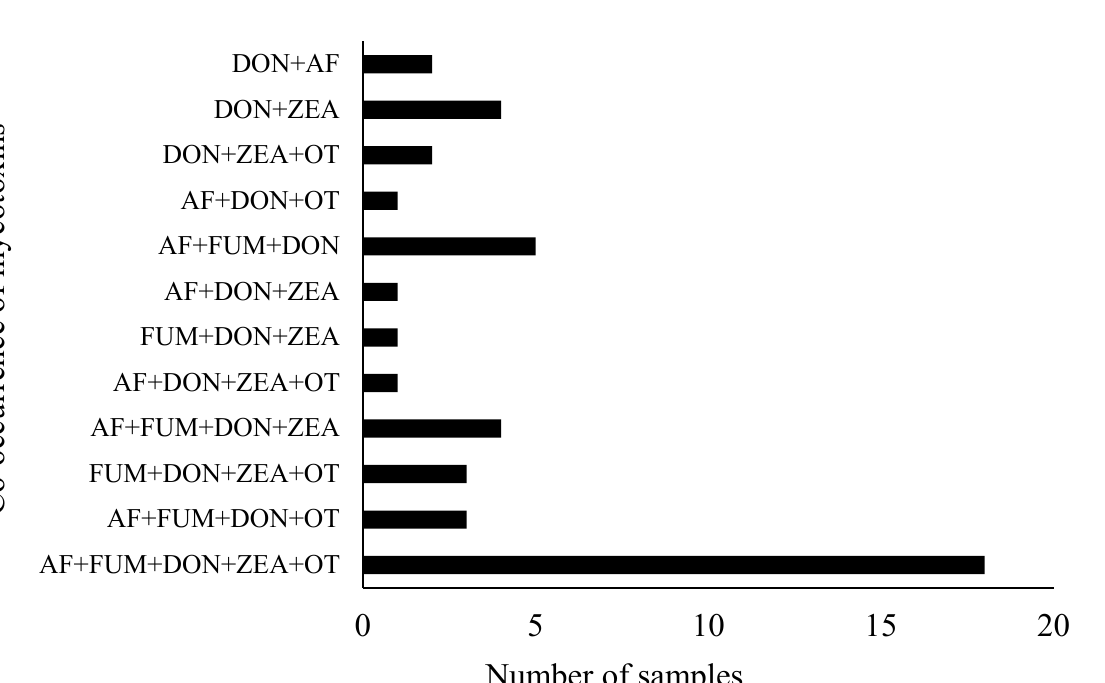
Figure 2. Types of co-occurrences of mycotoxins in positive samples of maize ( n = 45) collected from various provinces of Nepal. AF, aflatoxin. DON, deoxynivalenol. ZEA, zearalenone. OT, ochratoxin. FUM, fumonisin.